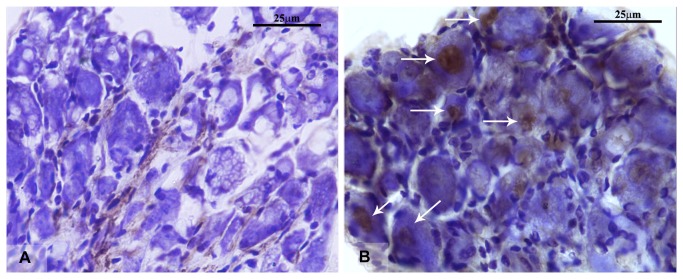
ATF3 immunolabeling, experiment 1.DRG were collected at the time of sacrifice for the immunohistochemical detection of the nuclear transcription factor ATF3. Thick (15 µm) cryostat sections of DRG were collected from vehicle (A) and bortezomib-treated (B) animals. Bortezomib treatment induced a marked nuclear ATF3 expression in DRG sensory neurons (arrows in B). No ATF3-positive nuclei were present in DRG of vehicle-treated mice.